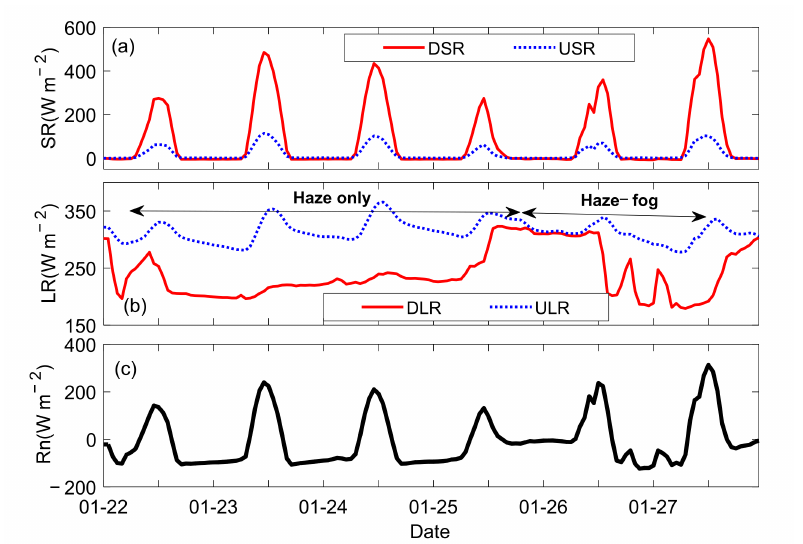
Figure 8. Variation in ( a ) downward shortwave radiation (DSR) and upward shortwave radiation (USR), ( b ) downward longwave radiation (DLR) and upward longwave radiation (ULR), and ( c ) net radiation ( R n ) observed at the IAE station in Shenyang during 22–27 January